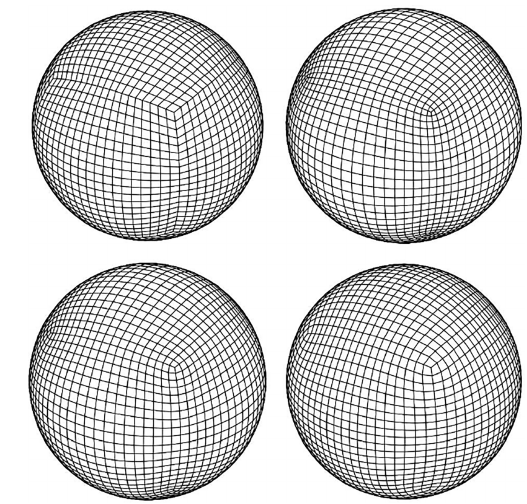
Figure 1. Cubed-spheres: (a) Upper left panel: gnomonic (Sadourny, 1972); ( b) upper-right panel: conformal (Ranˇci´c et al., 1996); (c) lower-left panel: smooth (SM) (Purser and Ranˇci´c, 1998); (d) lower-right panel: UJ (Ranˇci´c et al., 2017).